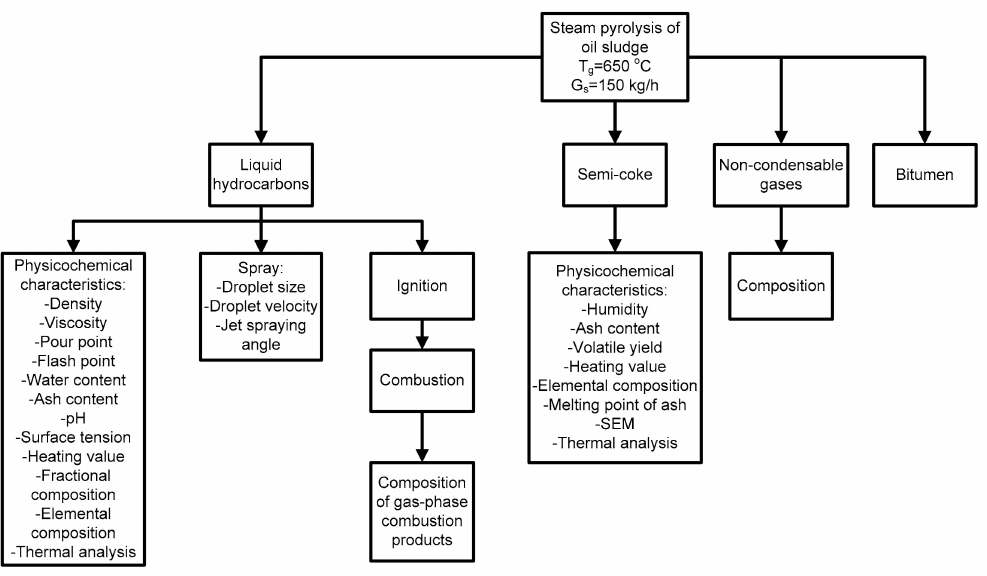
Figure 1. Methods structure of the